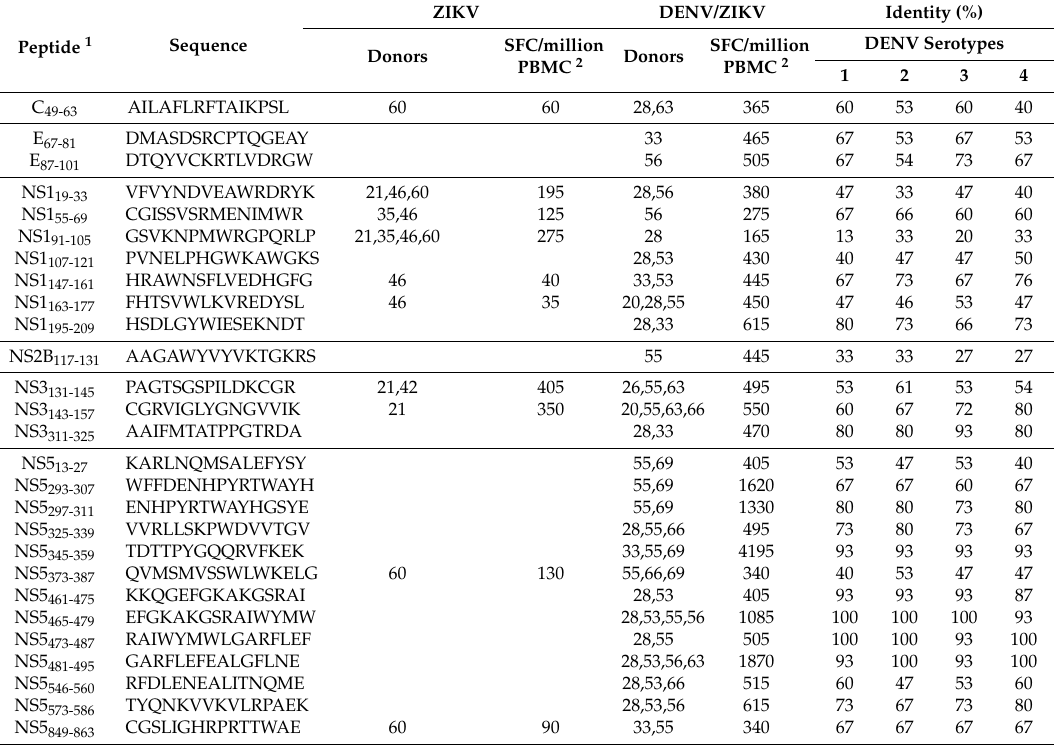
Table 3. Immunodominant epitopes in ZIKV- and DENV/ZIKV-immune